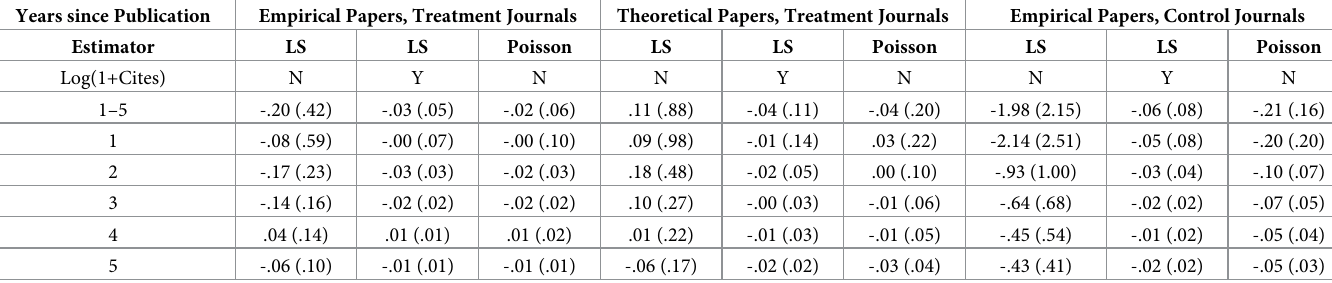
Table 1. Effect of policy switch, treating years after publication